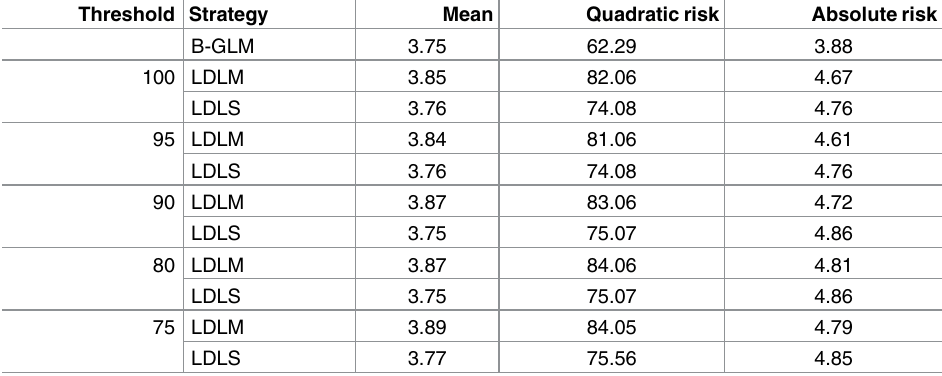
Table 4. Summary of predictions for B-GLM, LDLM, and LDLS on recoded variables. Threshold